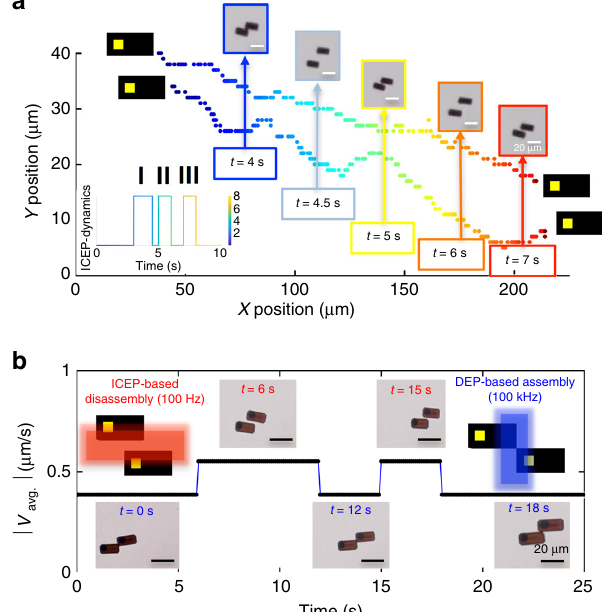
Fig. 3 Synchronized rebounding (cyclic oscillations from combined attraction and repulsion) and reversible assembly of N-I microparticles. a Trajectories of rebounding N-I microparticles (scale bar = 20 μ m), plotted in Cartesian coordinates, are shown at a fi xed electric fi eld strength ( E 2 = 54.4 kV 2 cm − 2 ) and frequency (100 Hz). The graphical inset also illustrates the synchronized rebounding motion of the N-I microparticles. The high pulses (I, II, and III) represent regions where the N-I microparticles are de fl ected off of each other. The low pulses represent regions where the N-I microparticles propel through the fl uid. These dynamics are shown in real time in Supplementary Movie 6 and Supplementary Movie 7.